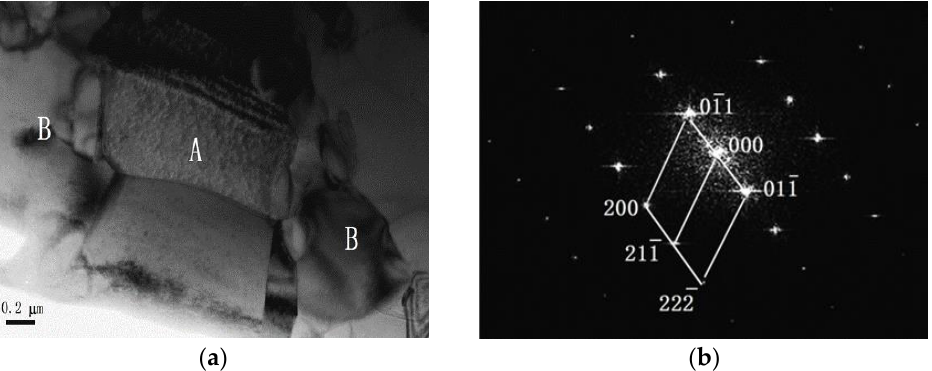
Figure 9. ( a ) Bright field TEM micrograph of a Ti-25Nb-6Zr alloy sintered at 1623 K. ( b ) FFT patterns of β -Ti with a BCC structure.